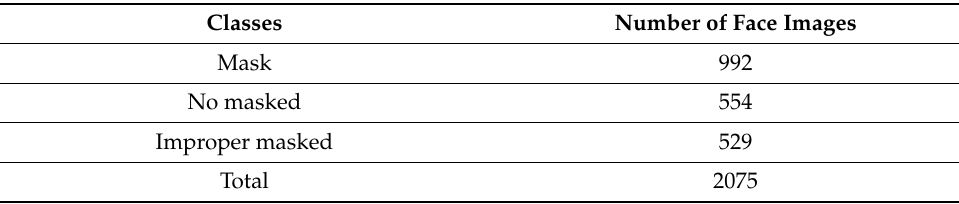
Figure 2. Sample images from the three classes in the dataset: ( a ) mask images, ( b ) no mask images, ( c ) improper mask images. The attributes of the collected face mask dataset are listed in Table 2. Table 2. Amount of class specific data within the dataset.